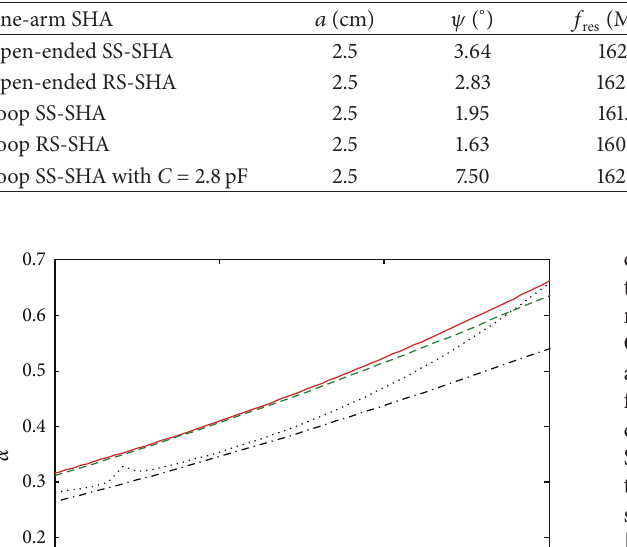
Table 3: Single-arm SHA configurations’ resonant properties.